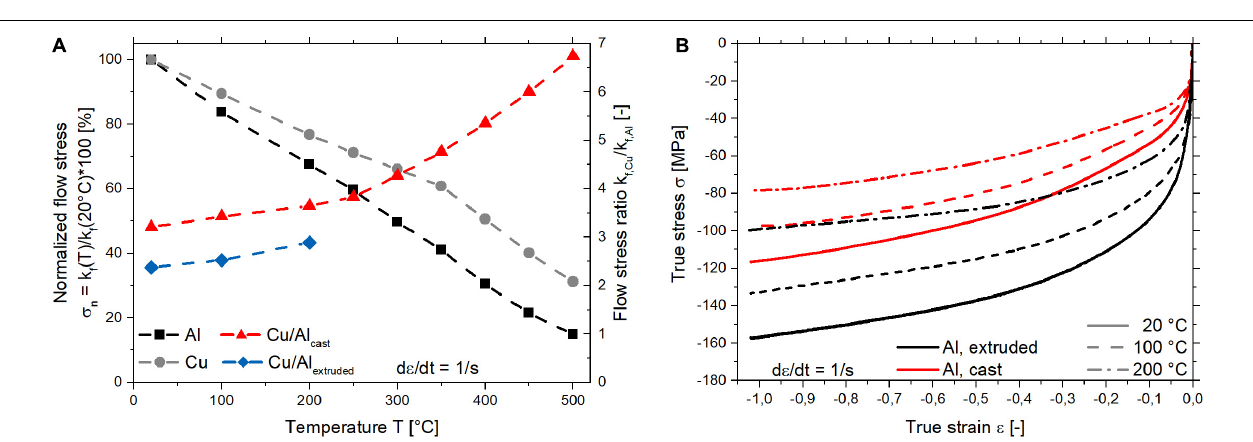
FIGURE 3 | (A) Normalized flow stress of cast EN AW-1080A and extruded and annealed CW004A at a logarithmic strain rate of ˙ ε = 1 s − 1 and true strain of ε = 1 as well as the flow stress ratio k f , Cu / k f , Al for cast and extruded aluminum in dependence of the temperature; (B) true stress-true strain curves of EN AW-1080A in cast and extruded condition at a strain rate of ˙ ε = 1 s − 1 .